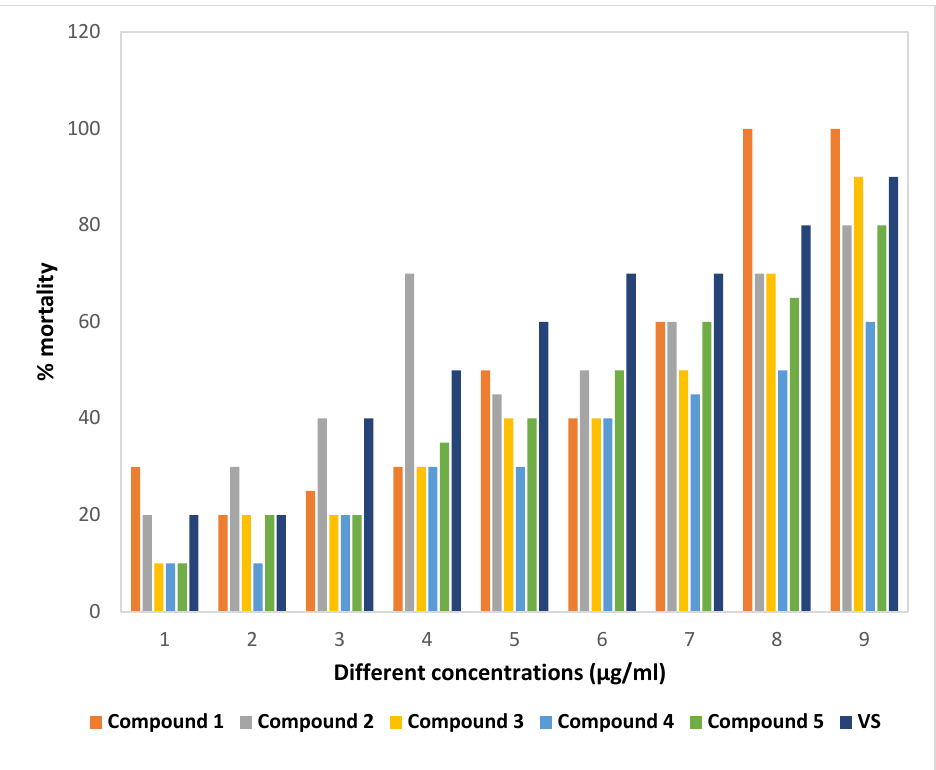
Figure 6. Percentage of mortality in Vincristine Sulphate (VS) and isolated phytochemicals of Glycosmis cyanocarpa where log concentrations − 0.10721, 0.19382, 0.49485, 0.79588, 1.09691, 1.39794, 1.69897 and 2.30103 µ g/mL are denoted serially from 1 to 9 in X-axis.